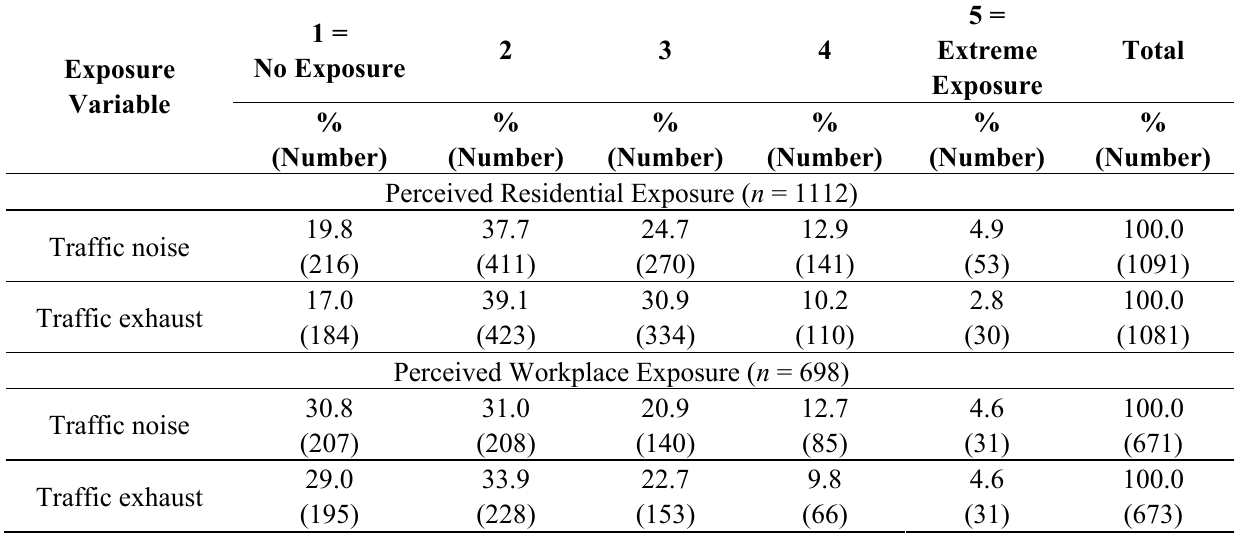
Table 2. Self-rated exposures to road traffic related noise and air